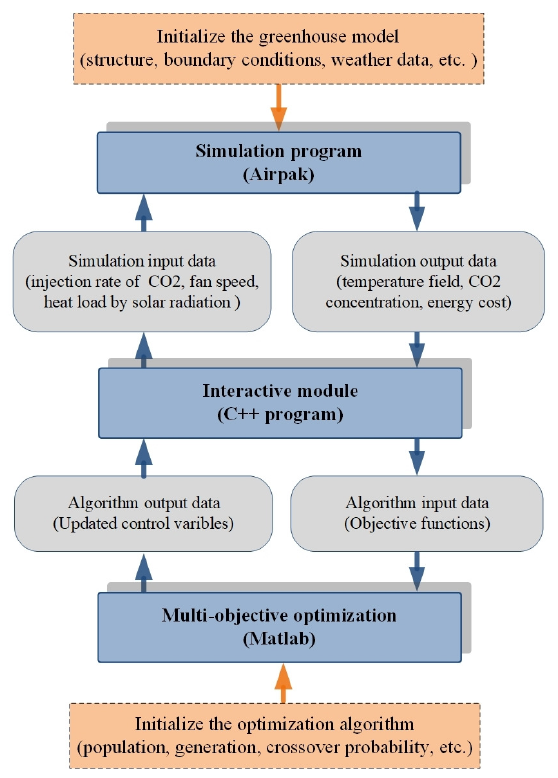
Figure 2. Interactive optimization